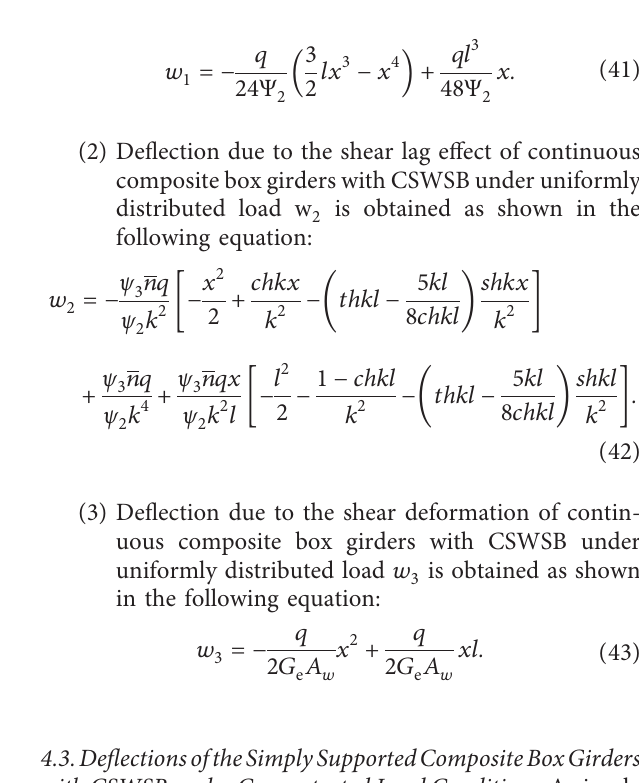
Figure 4: Schematic representation of two equal span continuous composite box girders with CSWSB under uniformly distributed load